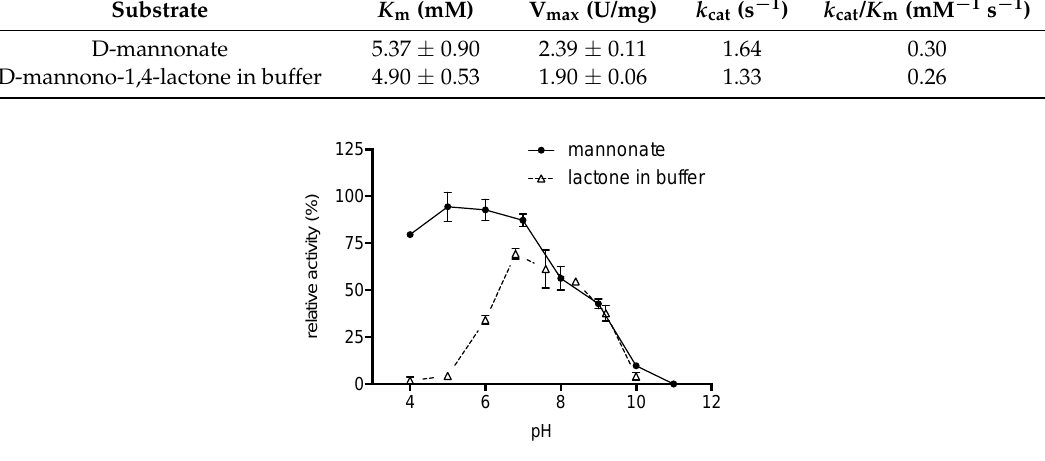
Figure 7. The pH optima of reactions with D-mannono-1,4-lactone prepared in buffer pH 7 (lactone in buffer) and with D-mannonate (prepared by hydrolysis with NaOH). Activity values are expressed as relative activity (%) normalised to the highest overall activity observed in the assay.